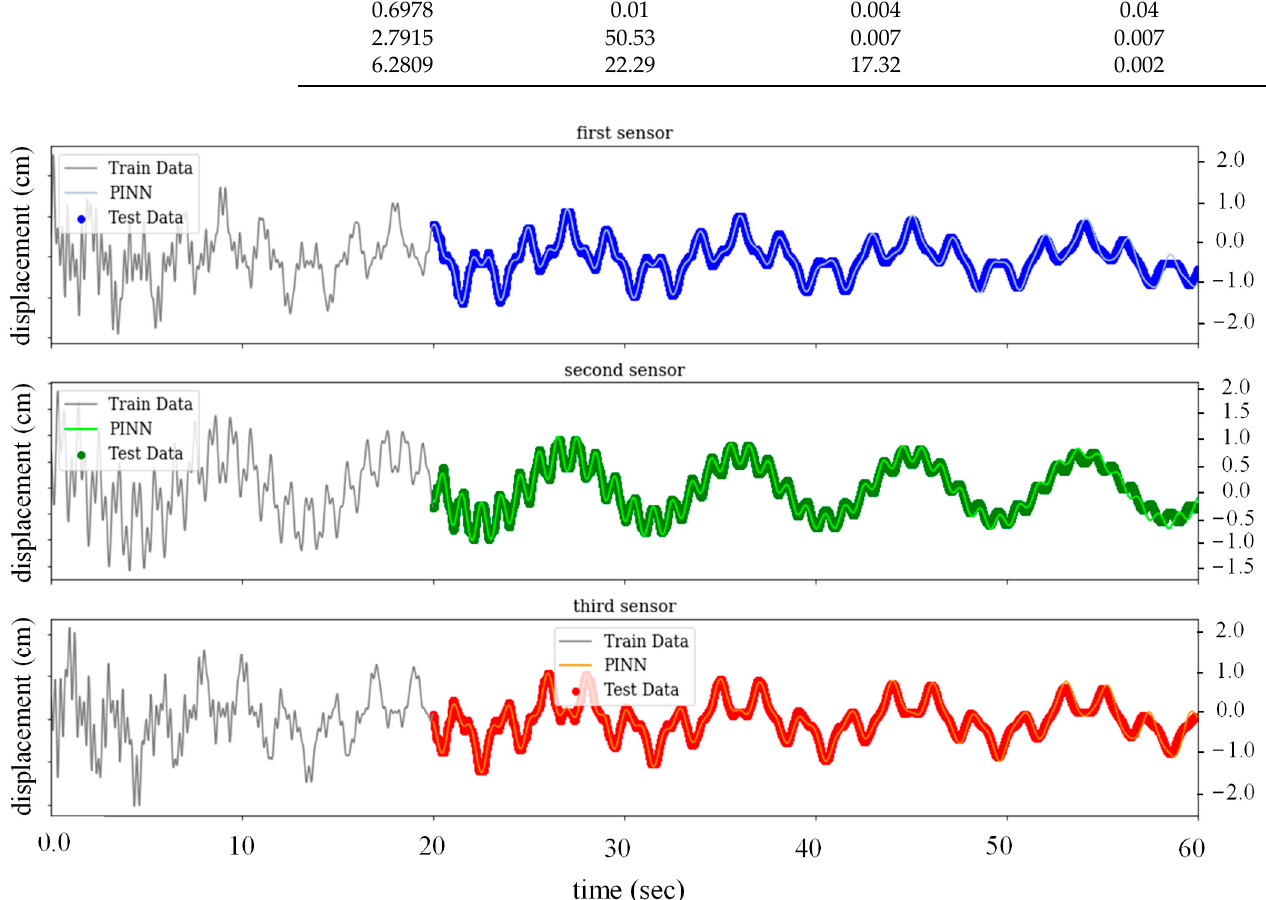
Figure 23. PINN state estimation with modified hidden layers for the test period.